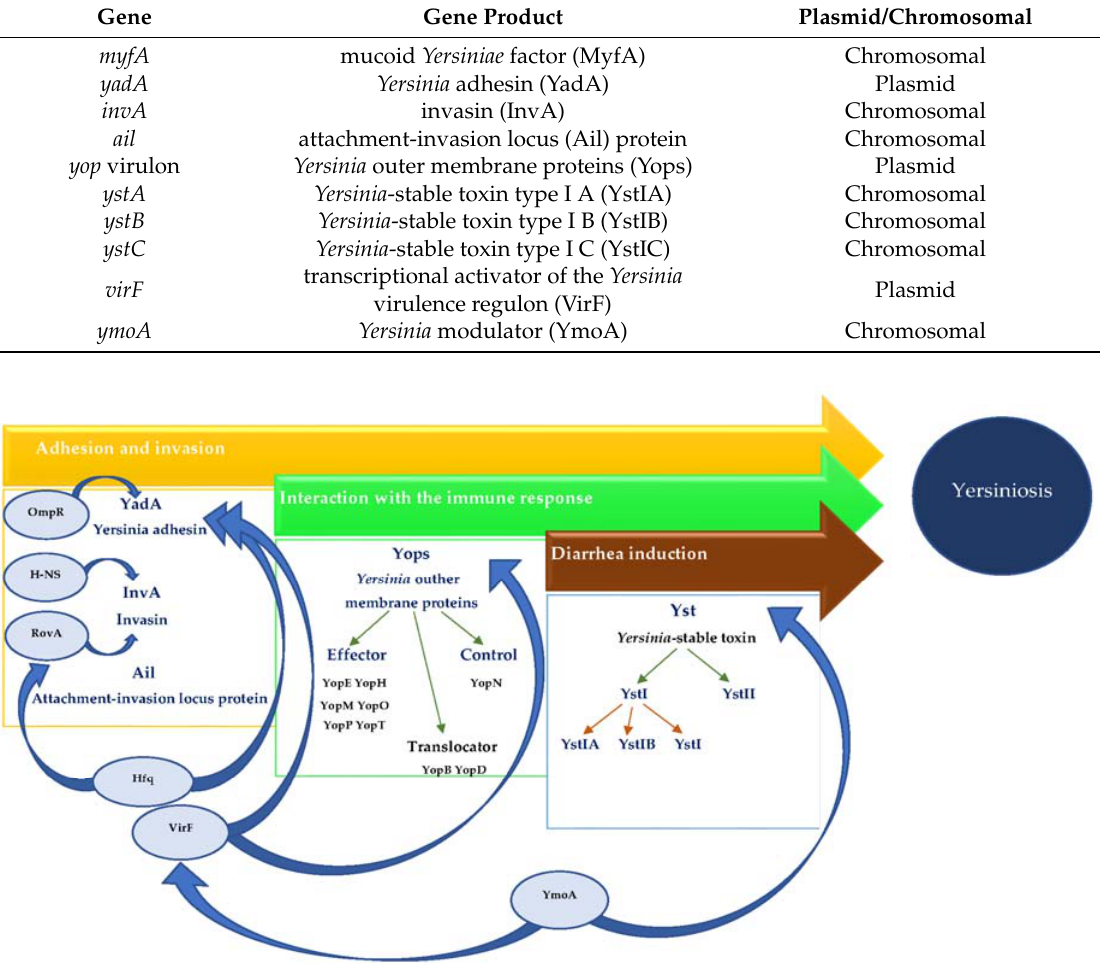
Figure 1. The role of selected regulatory genes in Yersinia enterocolitica virulence markers Table 1. Major virulence markers of Y. enterocolitica.